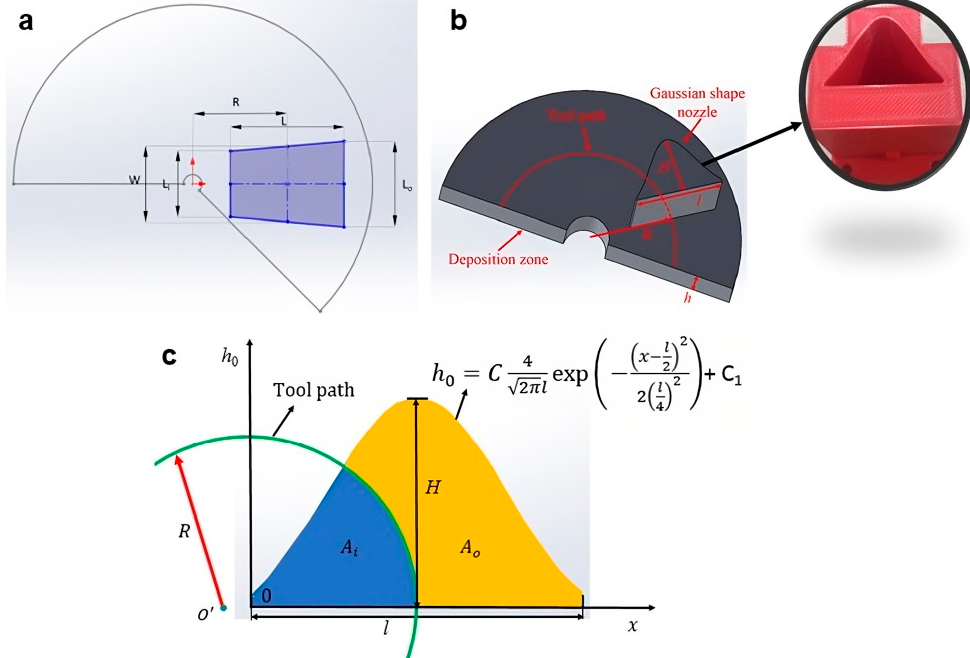
Figure 6. ( a ) Schematic of trapezoidal nozzle, ( b ) image of Gaussian nozzle and illustration of cementitious material deposition, and ( c ) cross-sectional profile of the Gaussian-shaped nozzle. To validate this hypothesis, additional numerical simulation was performed on a trapezoidal nozzle of LR = 1.2 and ϕ = 2.5 and the filament mass distribution was compared with a rectangular nozzle of the same ϕ value, i.e., ϕ = 2.5. Here, LR = 1.2 is selected to compensate for the material distribution inhomogeneity of the rectangular nozzle based on the simulation result. A comparison of the material mass distribution is depicted in Figure 7, where LR = 1.0 (Figure 7a) represents the rectangular nozzle. It can be clearly observed from the comparison of the two figures that the unfilled zone at the outer segment of the filament (blue region underneath the material) is significantly reduced when the trapezoidal nozzle is used. In all, the trapezoidal nozzle achieves a lower φ value of 1.24 as compared to the φ value of 1.29 for the rectangular nozzle. To further improve the homogeneity of the deposited material, trapezoidal nozzles with larger LR ratios should be used. The increase in LR introduces more materials on the outer segment of the filament and has the advantage of gravity-induced filament filling (see explanation in Figure 5 in the previous paragraph for the detailed illustration of this mechanism). However, when the LR becomes too large and the L i value reduces significantly, nozzle clogging can be a concern. Furthermore, with one control parameter, i.e., the LR ratio, to vary the extrudate material distribution, improving material homogeneity below an φ value of 1.20 for small toolpaths can be Figure 7. Cement ratio and velocity vector using a trapezoidal nozzle of LR of ( a ) 1.0 and ( b ) 1.2. To overcome the drawback of the trapezoidal nozzle, we further explored the utili- zation of Gaussian-shaped nozzles. As shown in Figure 6b,c, the width of this nozzle var- ies with the nozzle length and takes the form of a Gaussian distribution. The Gaussian profile can be characterized by Equation (5) where h o denotes the nozzle length, and H and l are the maximum nozzle length and width of the Gaussian-shaped nozzle, respec- tively. In addition, µ and σ are the mean and standard deviations, and C and C l are con- stants which can be used as fitting parameters to realize the desired Gaussian profile. Such a nozzle shape has several advantages over rectangular and trapezoidal nozzles. Firstly, studies have shown that the Gaussian nozzle produces a lower Poiseuille number when compared to rectangular and trapezoidal nozzles [15]. This reduces the tendency of nozzle blockage due to high differential pressure [16] and enables a continuous and smooth flow of materials. Secondly, the four fitting parameters of Equation (5) also increase the design freedom for the optimized Gaussian profile to achieve the required mass distribution